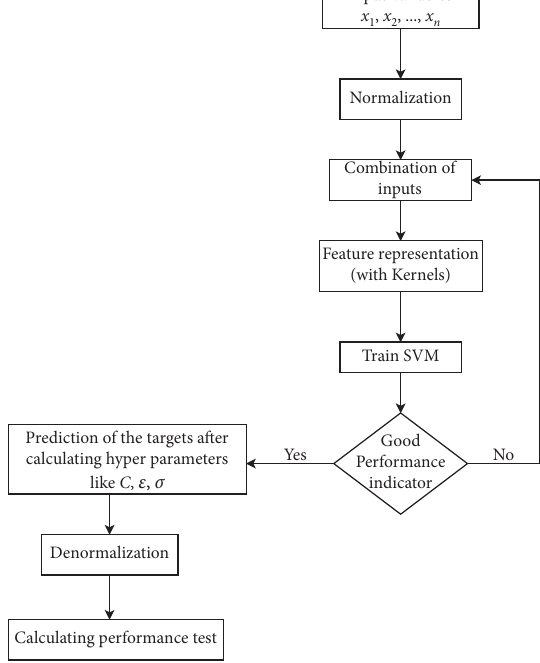
Figure 4: Flowchart of establishing the SVM Table 2: Input combination set of several forecasting models.